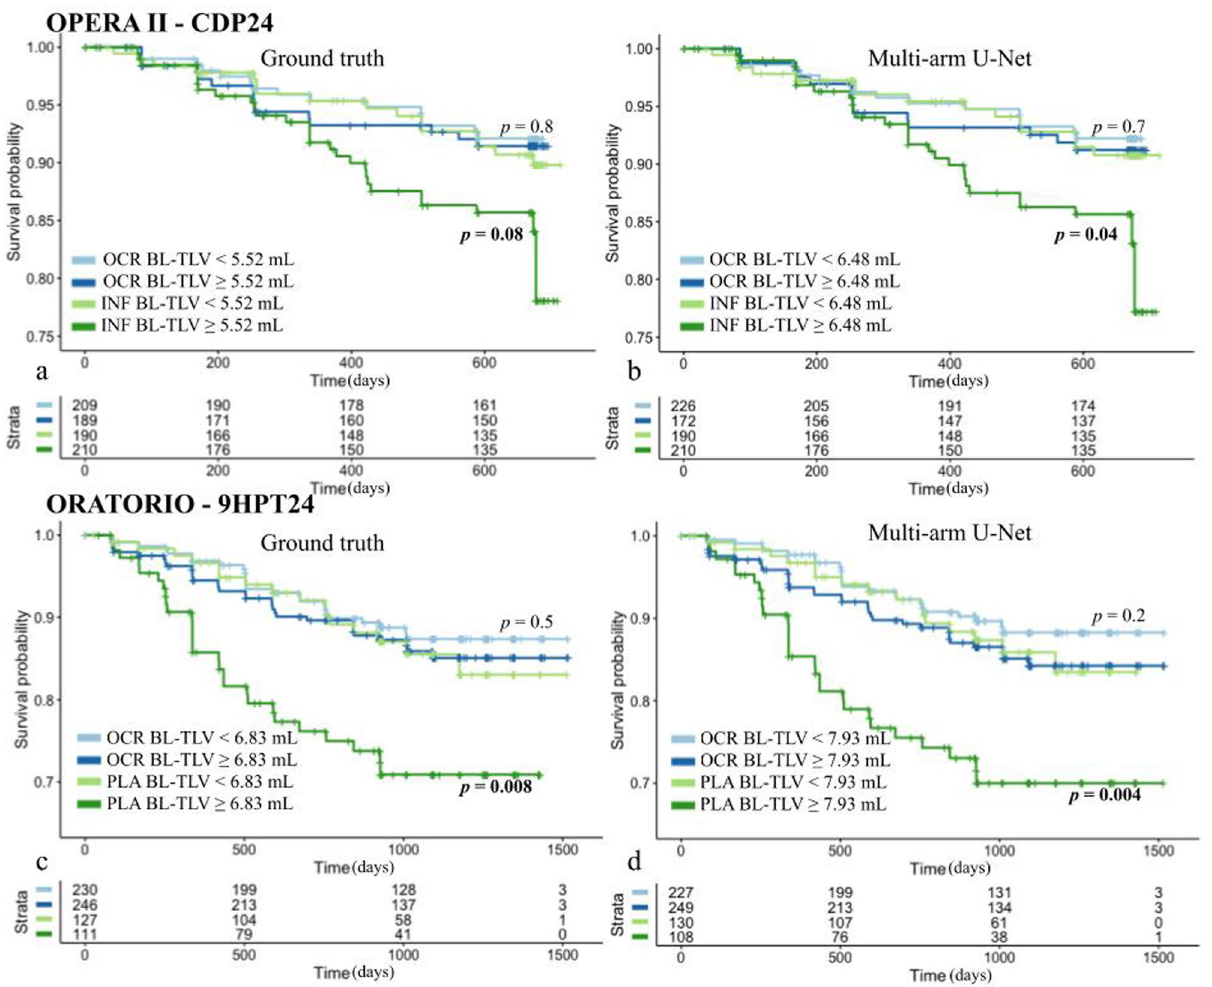
Figure 4. Association of baseline T2 TLV with confirmed disability progression sustained for at least 24 weeks in MS clinical trials. KM curves of CDP24 dichotomized by median T2 TLV at baseline from GT masks ( a ) and predicted masks ( b ) showed a good separation in the interferon arm, but not in the ocrelizumab arm, of the OPERA II trial. KM curves of 9HPT24 dichotomized by median baseline T2 TLV revealed a clear separation in the placebo arm when using GT masks ( c ) and predicted masks ( d ), but not in the Ocrelizumab arm of the ORATORIO trial. The median values were estimated over the whole cohort and applied to the treatment and control arms separately. P values are from a log-rank test to compare the KM curves. 9HPT24 nine-hole peg test (sustained for at least 24 weeks), BL baseline, CDP24 confirmed disability progression (sustained for at least 24 weeks), GT ground truth, IFN interferon beta-1-a, KM Kaplan–Meier, OCR ocrelizumab, PLA placebo, TLV total lesion However, as these models were trained and tested on different datasets, a direct comparison of their performances remains unfavorable. Hence, the next set of models were evaluated on the MICCAI 2016 dataset. Joint segmentation of MS T2 lesions and brain anatomical regions improved T2 lesion segmentation performance 7 and model generalization with varying MRI contrast 6 . The 2.5D DeepSCAN model had a consid- erably lower number of parameters (< 0.5 M) than the multi-arm U-Net. The 3D nnU-Net and 2.5D DeepSCAN models trained on RWD ( n = 122) from a single center and evaluated against the consensus masks of the training set of the MICCAI 2016 ( n = 15) dataset 7 achieved mean DCs of 0.61 and 0.66 for nnU-Net and DeepSCAN, respectively, when trained to segment T2 lesions and brain regions jointly, and mean DCs of 0.62 and 0.6, respectively, when trained to segment T2 lesions only. Correspondingly, our model trained on the OPERA I trial dataset and evaluated against the consensus masks of the MICCAI 2016 ( n = 53; train and test sets) dataset had a mean DC of 0.62, and a mean DC of 0.54 (Supplementary Table S1) when evaluated against individual raters. The mean DC against the seven individual raters was 0.53 and 0.59 for joint segmentation; 0.54 and 0.53 for segmenting T2 lesions only with nnU-Net and DeepSCAN models and 0.57 with the generative model 6 . Of note, the MICCAI 2016 dataset was acquired with a standardized MRI protocol, and it was down-sampled to match the resolution of the clinical trial datasets in our analysis. Therefore, a reduction in the agreement among the various raters and model performance metrics was expected. Nonetheless, our model generalized reasonably